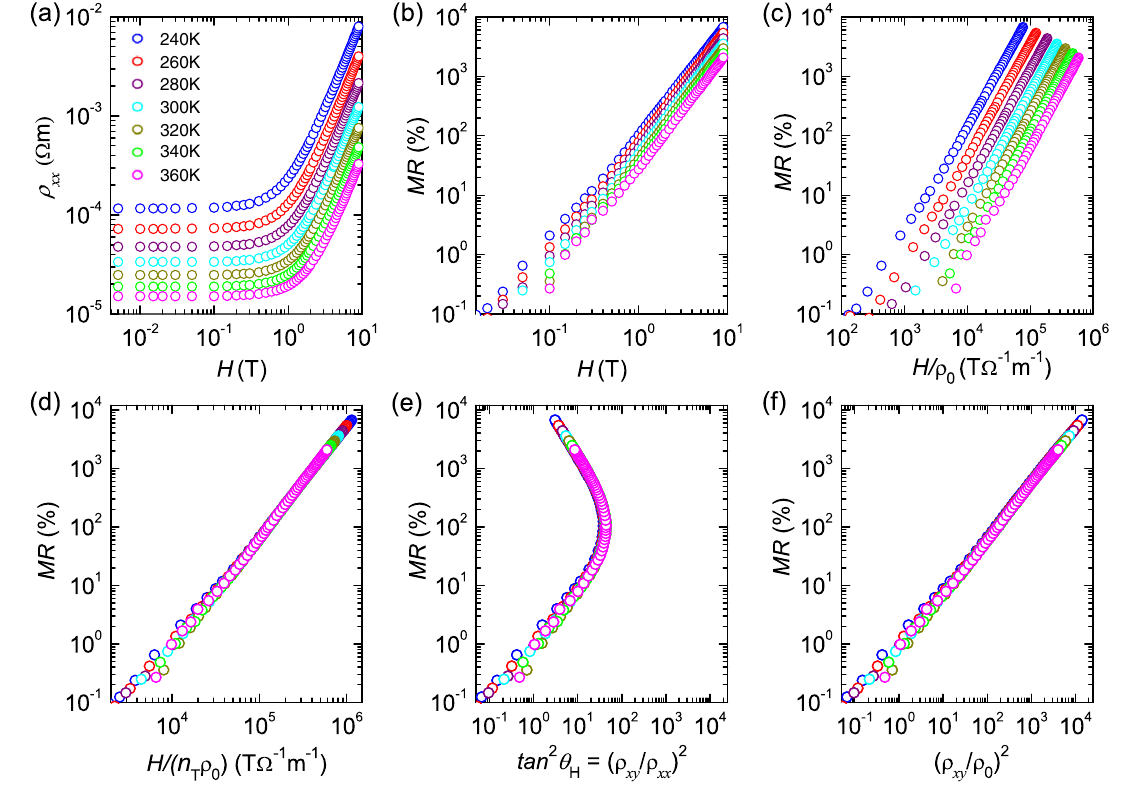
ð H Þ curves at various temperatures. xx